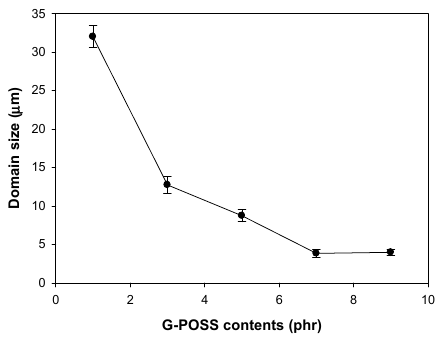
Figure 3. Variation of dispersed domain size in blend with G-POSS content.